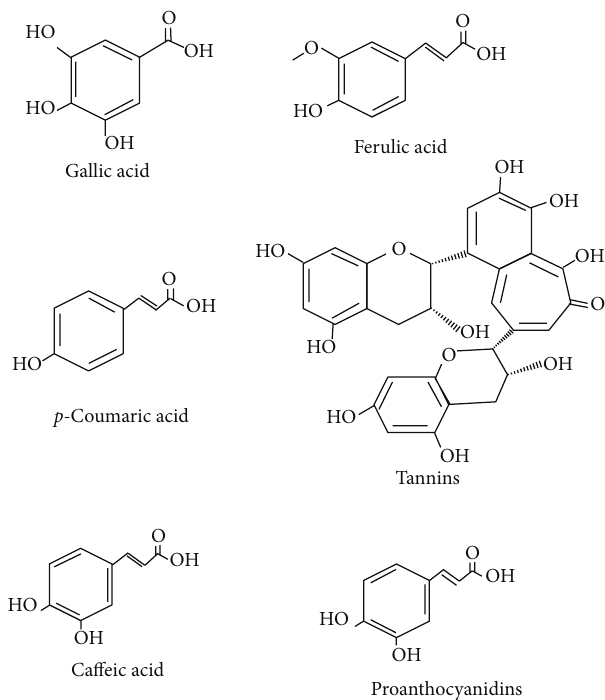
Figure 1: Chemical structures of common phenolics in